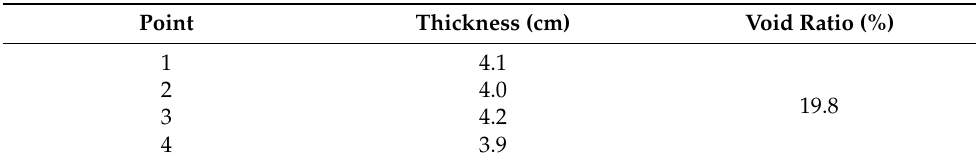
Table 8. Simulated pavement